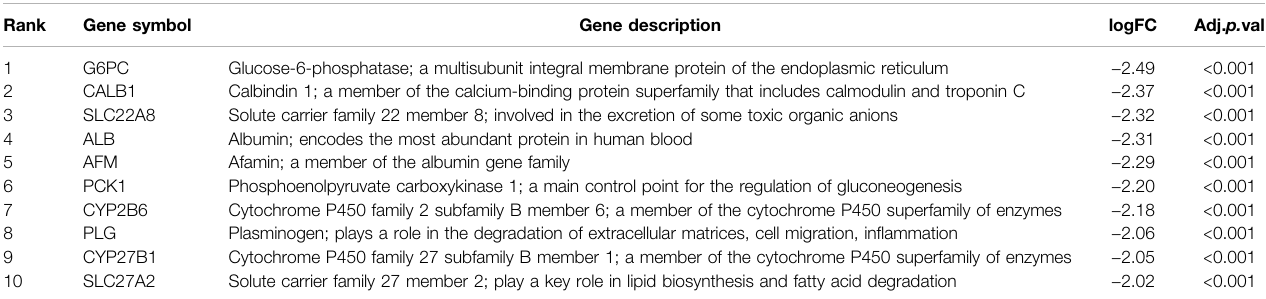
TABLE 2 | Top 10 down-regulation differentially expressed genes in MN